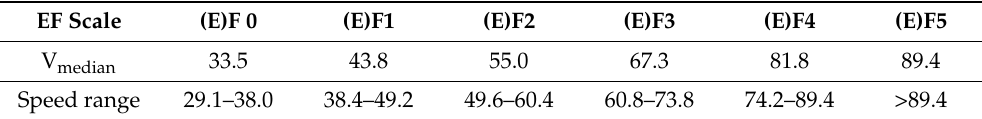
Table 1. Enhanced F scale of tornado and wind speed (m s − 1